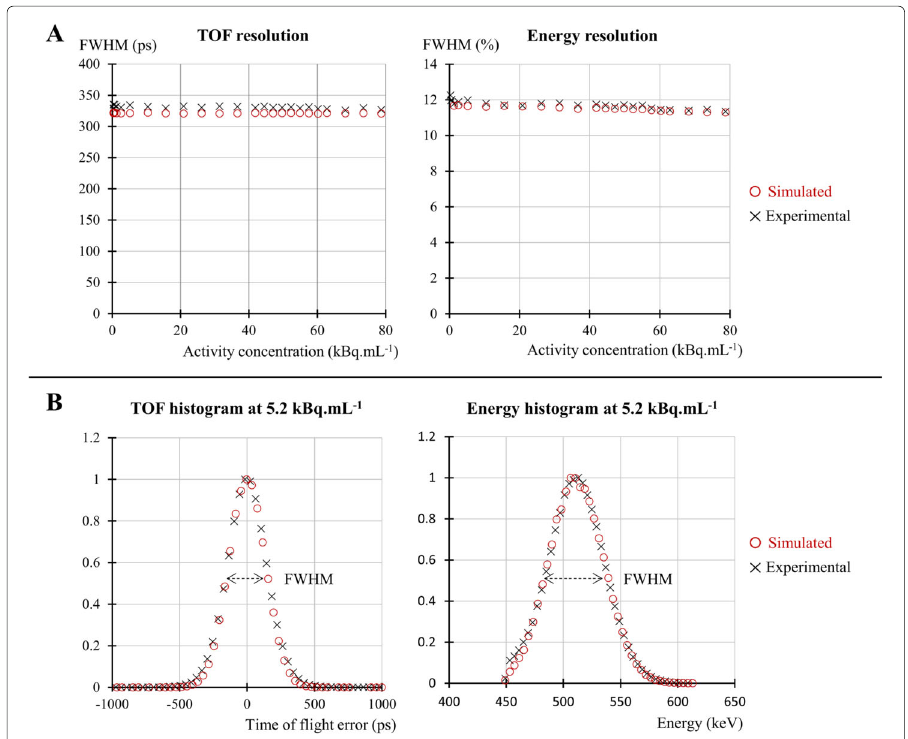
Fig. 4 a TOF and energy resolutions according to activity concentrations for both simulated (o) and experimental (x) data. b Example, for 5.2 kBq mL − 1 activity concentration, of the normalized TOF and energy histograms used to compute the FWHM